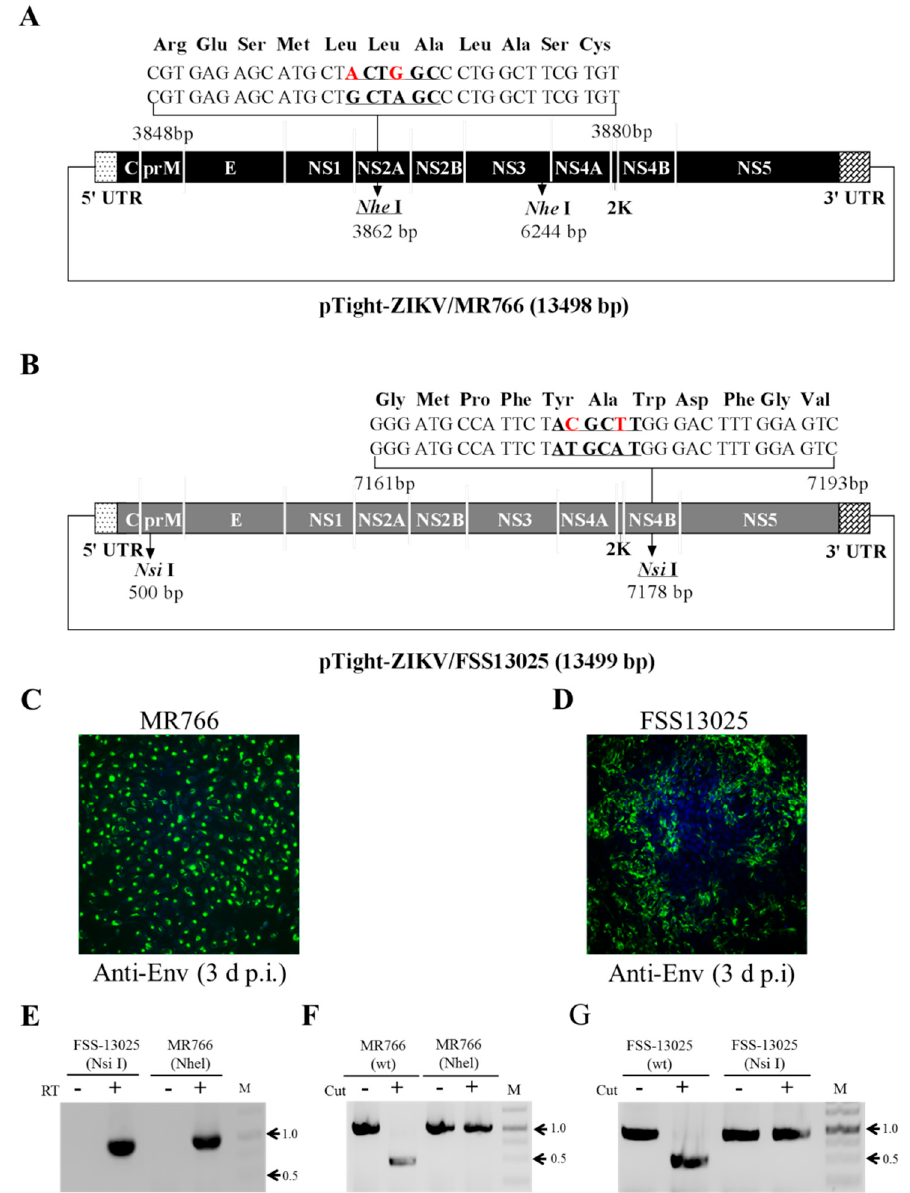
Figure 5. Confirmation of cDNA-derived ZIKV by detection of genetic markers. ( A ) Diagram of the pTight-ZIKV/MR766 DNA containing two nucleotide mutations as genetic markers. The Nhe I site at the nucleotide 3862 of the MR766 cDNA was mutated by changing two nucleotides (red) that do not alter amino acids (shown on the top). ( B ) Diagram of the pTight-ZIKV/FSS13025 DNA containing two nucleotide mutations at the 7178 Nsi I site of the FSS13025 cDNA as genetic markers. ( C , D ) Validation of cDNA-derived infectious ZIKV by IFA. The genetic markers-harboring pTight-ZIKV/MR766 and pTight-ZIKV/FSS13025 DNAs were co-transfected into Vero cells as described in Figure 3. The supernatants of the DNA-transfected cells were used for infection of Vero cells. At 3 d p.i., the expression of the E protein of MR766 ( C ) or FSS13025 ( D ) was detected by IFA. The images of (C) and (D) were taken under 200× magnification. The vRNAs were extracted from the supernatants using a Qiagen viral RNA isolation kit and used for reverse transcription (RT, indicated by +). The RT products were amplified by PCR using vRNA without RT as controls ( E ). The RT-PCR products from MR766 vRNA were digested with the restriction enzyme Nhe I ( F ), whereas the RT-PCR products of FSS13025 were cut with Nsi I ( G ). Wild type MR766 and FSS13025 RT-PCR products were used as controls.